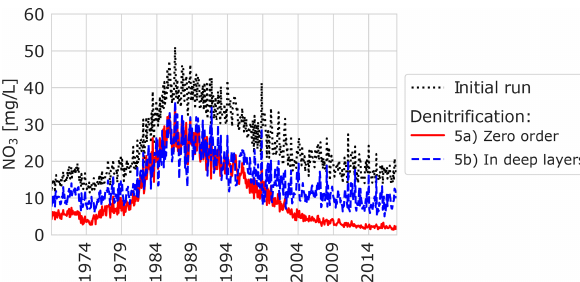
Figure 7. Effect of denitrification for the upstream part of the catch- ment using different conceptualizations, i.e. zero-order denitrifica- tion (5a) and denitrification in deep layers